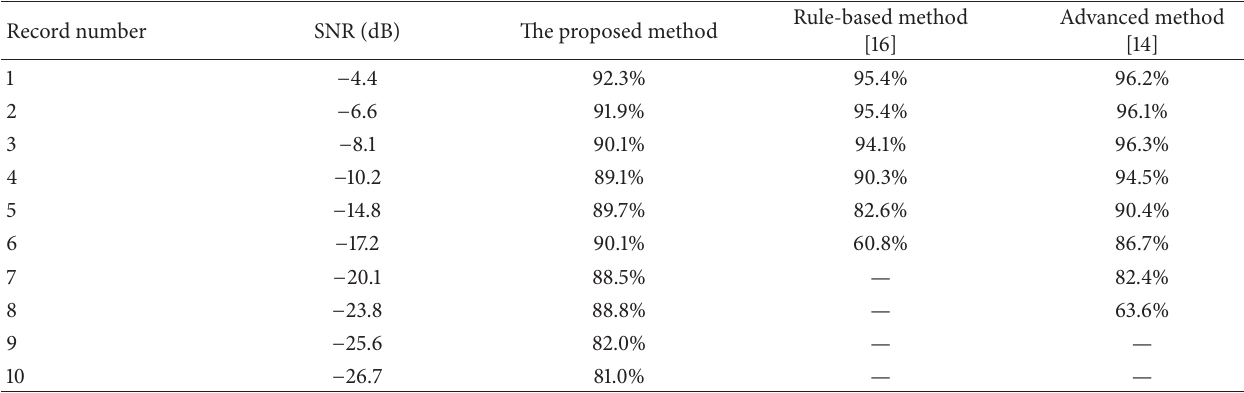
Table 2: Performance